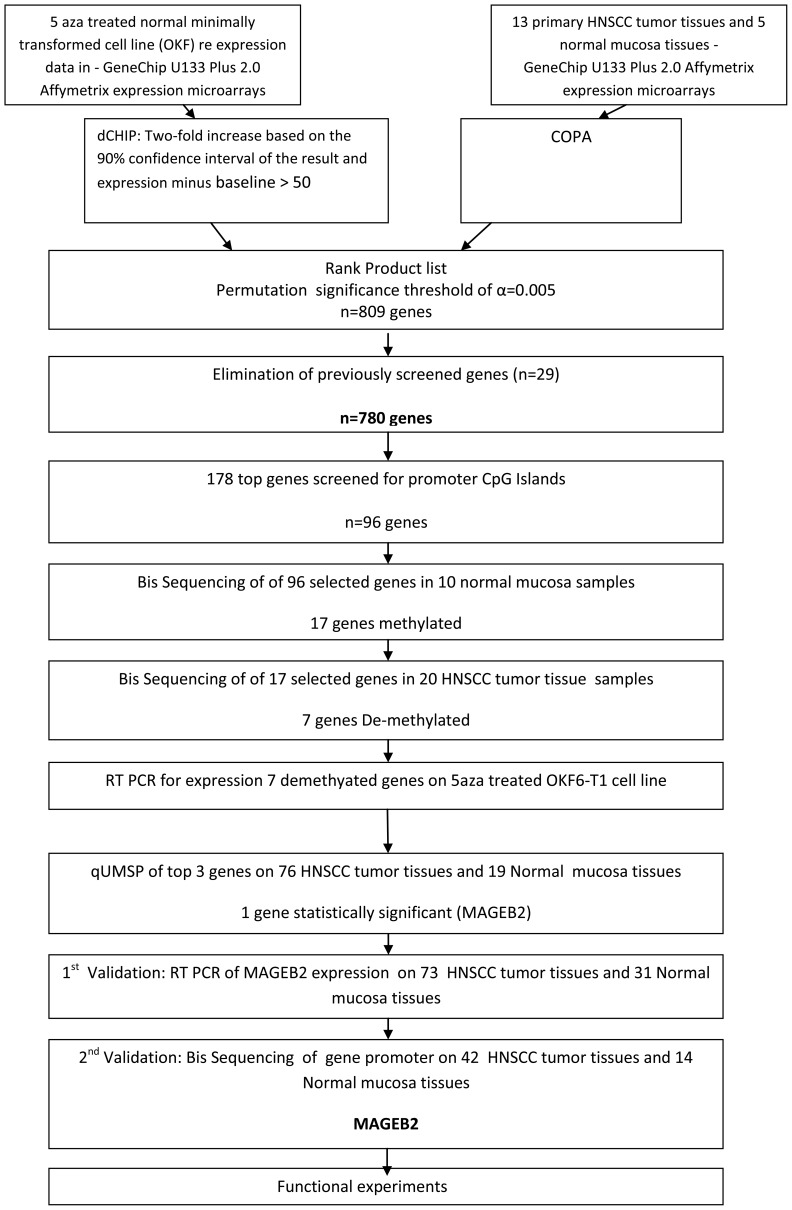
Study Flowchart.